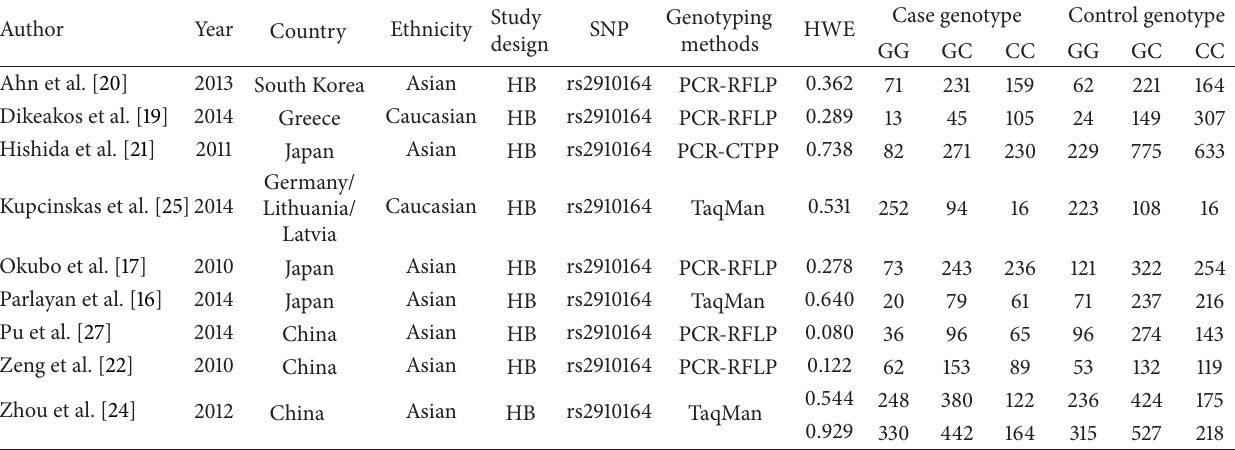
Table 1: Characteristics of included studies on